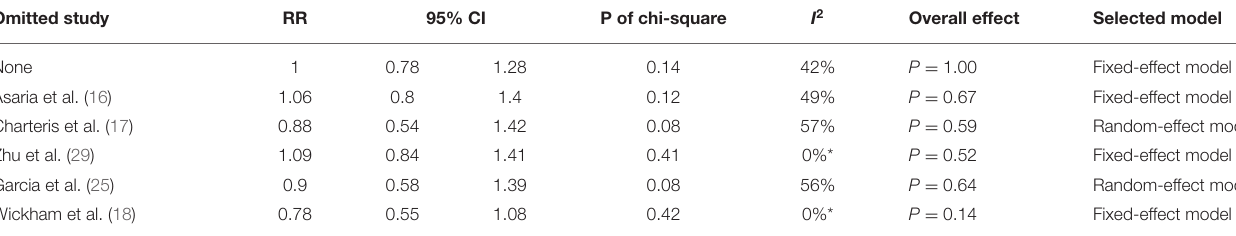
TABLE 5 | Sensitivity analysis for additional outcome: number of patients underwent vitreoretinal